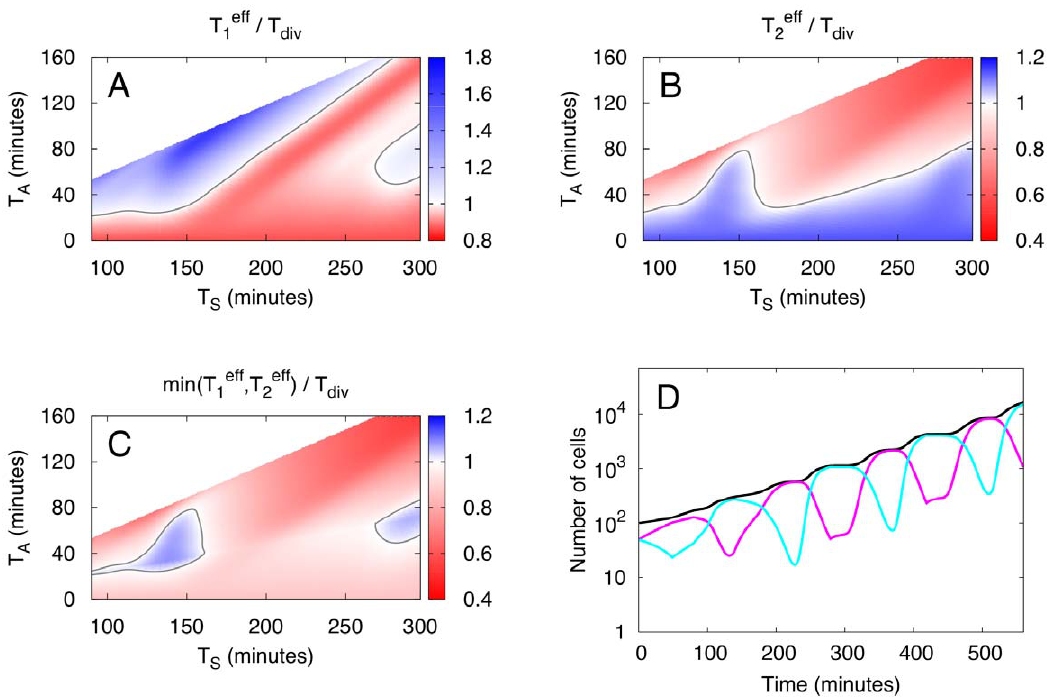
Figure 7. Population showing phenotypic variation according to model 2 growing without adaptation after a strategy switch. For ~ 0 , T eff p ~ 1 and T B = T div and T eff = T div are shown as function of switching time T S and adaptation time T A in Figs. A and B, respectively. Fig. C A 1 2 shows min( T eff , T eff ) = T div thus comparing the diversified population with the faster growing homogeneous population. In Fig. D the total number of 1 2 cells N ( t ) as function of time t is shown for the diversified population (black curve). The subpopulations growing with strategy 1 and 2 are shown in magenta and cyan, respectively. Data shown are for T A ~ 50min and T S ~ 140min . In all cases the birth mass noise is 8% and data are only shown for T A v 0 : 6 T S .